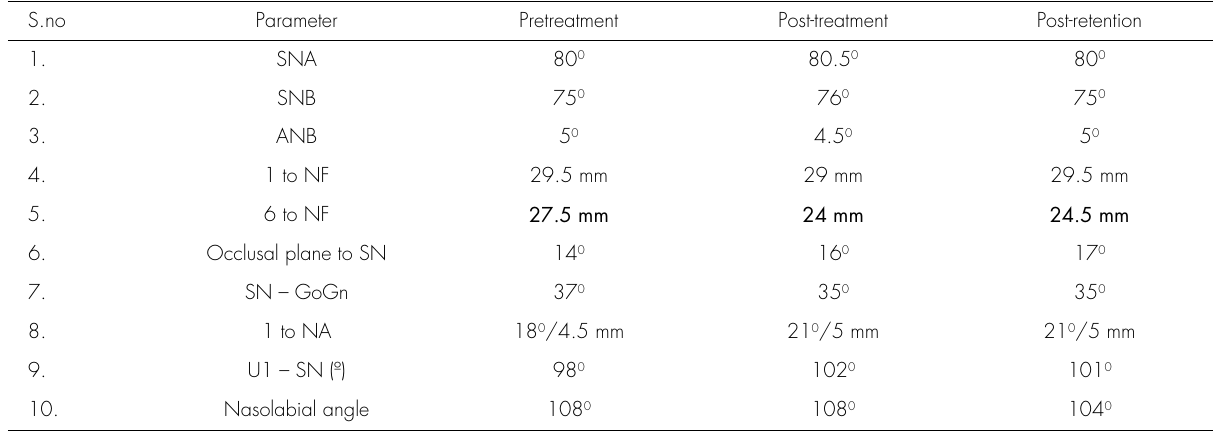
Bolded measurements indicate significant molar intrusion.